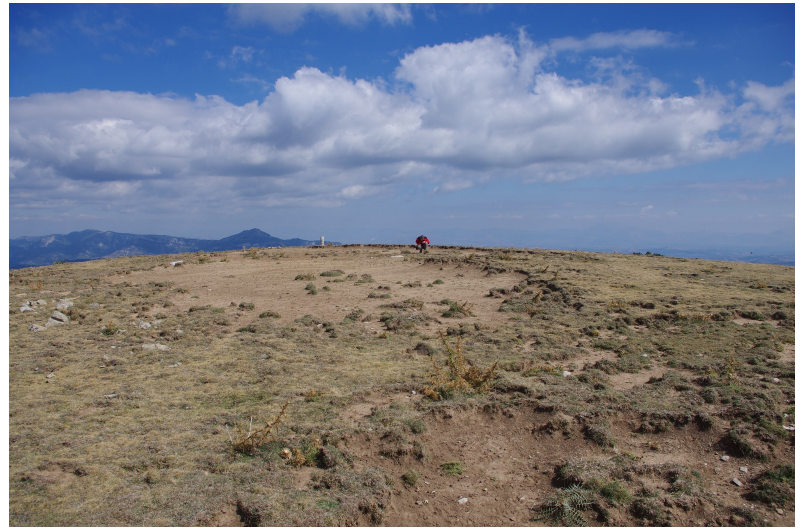
Figure 22. The top of Mount Kirkuri from the south, from which come lithic artefacts of different cultural periods and Bronze Age arrowheads (photograph by E. Starnini, 2013). Among the latter, the area yielded four fragmented arrowheads made from non-local chert, by bifacial, covering, flat retouch. They consist of one, almost complete, barbed-and- tanged, triangular type (Figure 7, n. 1), two have a concave base (Figure 7, n. 3 and 4), and one is too small a fragment to have an idea of its original shape (Figure 7, n. 6). From a techno-typological point of view, all the Kirkuri arrowheads can be attributed to the Bronze Age. 5.6. Mount Anitsa (Anitsa and NTS) Mount Anitsa has played an important role in the prehistory and recent history of the Samarina region, for reasons that can be partly explained by the events that took place during WWII [80]. The reasons why the conquest of Mount Anitsa was so important for the end of the war are to be found in the strategic location and shape of the mountain, which gives access to the Western Macedonian Plain, in the east, and offers good visibility from which all the valleys around can be controlled. Given these features, it is not surpris- ing that a Middle/Late Bronze Age site (Sam-29) was established on its top (1705 m a.s.l.). The 2 × 3 m excavation trench opened in 2007 did not yield any evidence of archaeological features. A few characteristic Bronze Age fine-ware shards were recovered [81], and a few Quercus sp. charcoal pieces, one of which was radiocarbon-dated to 3095 ± 35 BP (GrA- 51015). Important discoveries were also made on the upper slope of the same mountain, fac- ing south. Dozens of shatters and hyper-microflakelets knapped from Vikos “black chert” were found scattered over a surface of ca. 5 square metres associated with a partly re- touched large flake of the same raw material, most probably the rough-out of an